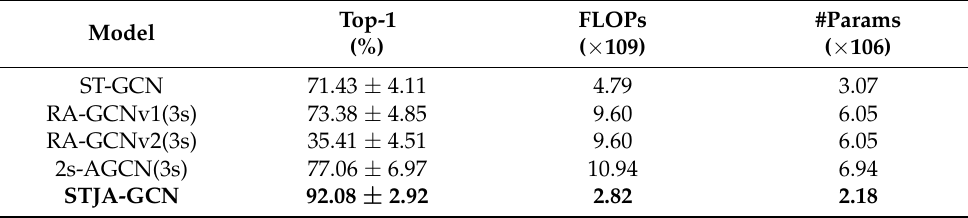
Table 5. Comparison of results on